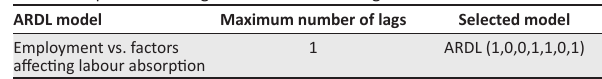
TABLE 4: Optimal Autoregressive Distributed Lag model selected. ARDL model Maximum number of lags Selected model Employment vs. factors affecting labour